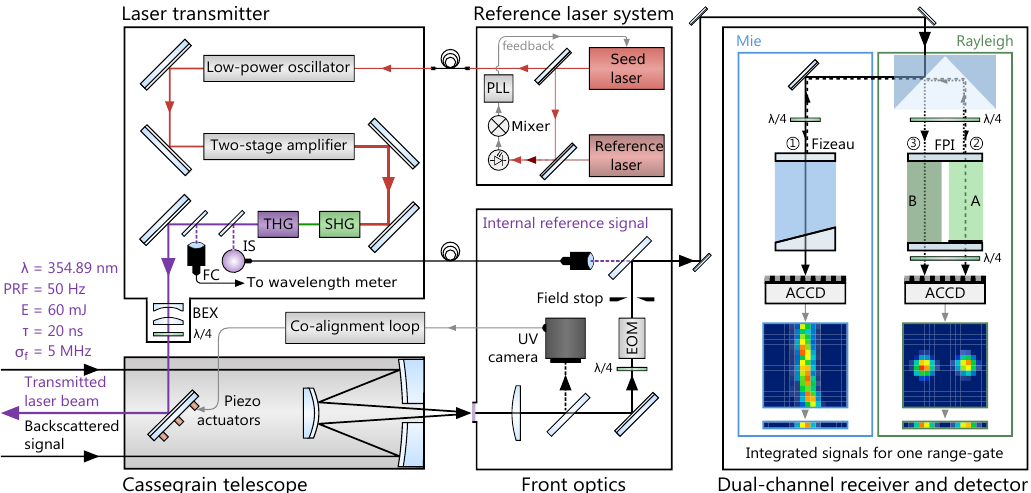
Figure 1. Schematic of the ALADIN Airborne Demonstrator (A2D) wind lidar instrument consisting of an injection-seeded, frequency- tripled laser transmitter, a Cassegrain telescope, front optics and a dual-channel receiver. PLL: phase locked loop; SHG: second harmonic generator; THG: third harmonic generator; IS: integrating sphere; FC: fibre coupler; BEX: beam expander; EOM: electro-optic modulator; FPI: Fabry–Pérot interferometer; ACCD: accumulation charge-coupled device.